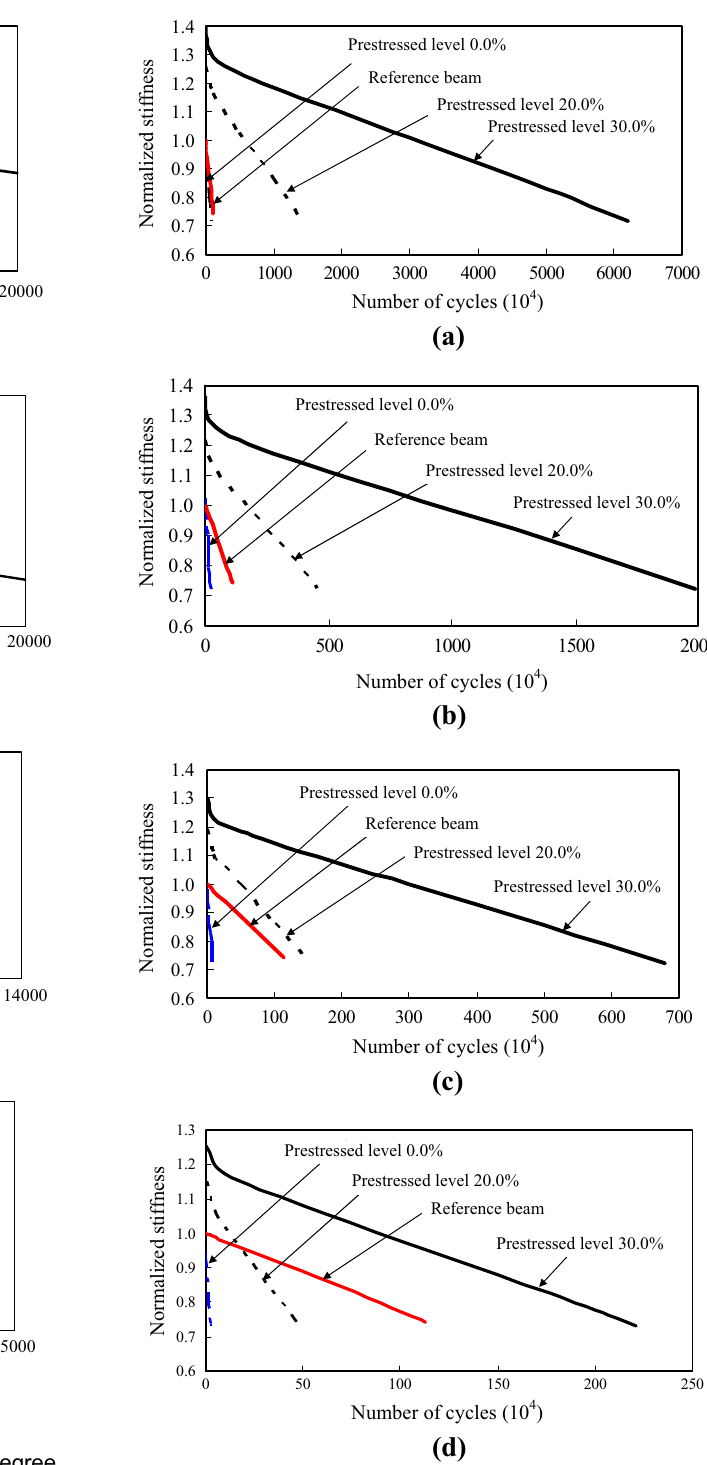
Fig. 7 Normalized stiffness degradation versus number of cycles: a 5% corrosion degree, b 10% corrosion degree, c 15% corrosion degree, and d 20% corrosion